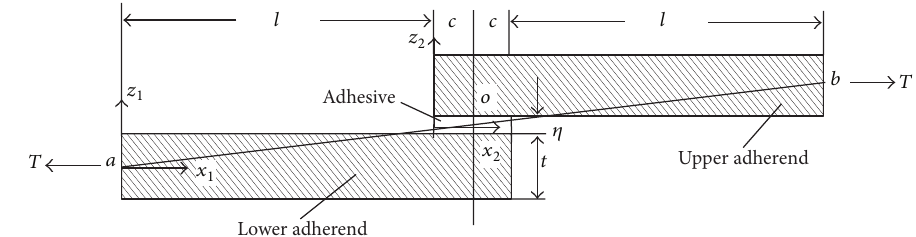
Figure 2: A single-lap-jointed